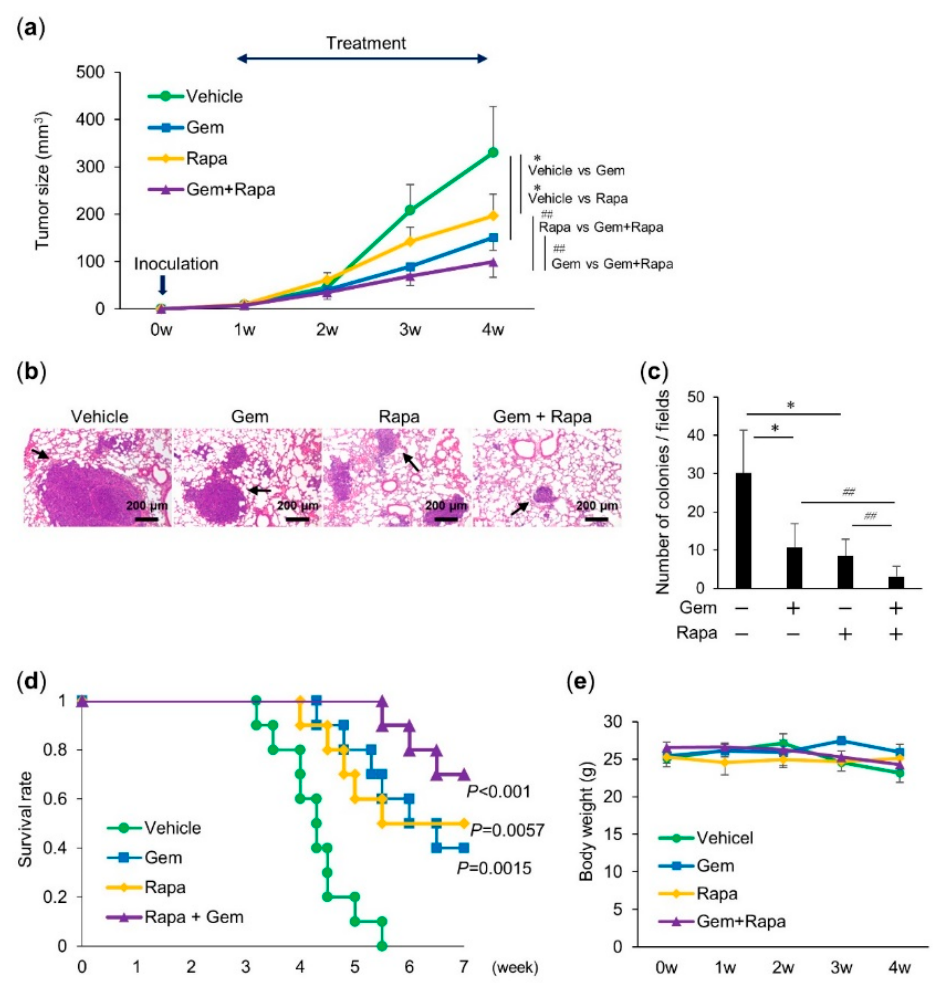
Figure 4. Combined administration of Gem and Rapa reduced the growth and metastasis of LM8 cells in a murine subcutaneous allograft model. ( a ) C3H mice were subcutaneously injected with LM8 cells and treated with Gem, Rapa, or the combination. Tumor sizes were measured weekly. Values represent the mean ± SD ( n = 10 tumors). * p < 0.05 compared with the vehicle. ## p < 0.05 vs. Gem or Rapa alone. ( b ) Representative micrographs of the lungs (hematoxylin–eosin staining). Arrows indicate metastatic nodules; bar = 200 µ m. ( c ) Quantitative analysis of metastatic nodules in the lungs. Results are shown as mean ± SD. * p < 0.05 compared with the vehicle. ## p < 0.05 vs. Gem or Rapa alone. ( d ) Survival rate was determined based on a Kaplan–Meier plot ( n = 10). Data were analyzed using a log-rank test. ( e ) The weights of the mice were measured weekly for 4 weeks. Data are shown as the mean ± SD ( n = 10). See Supplementary Figure S9 for a schematic flowchart and photos of tumor-bearing mice.